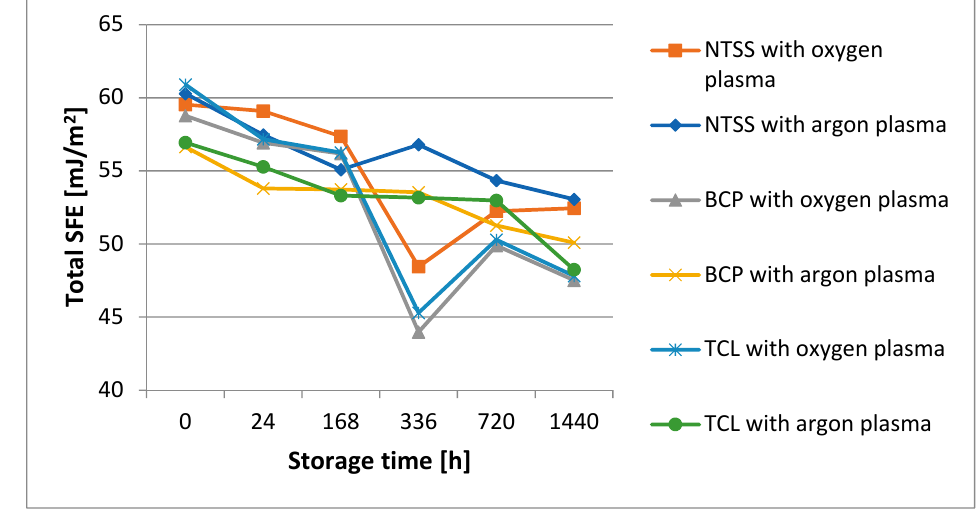
Figure 9. SFE changes due to storage.